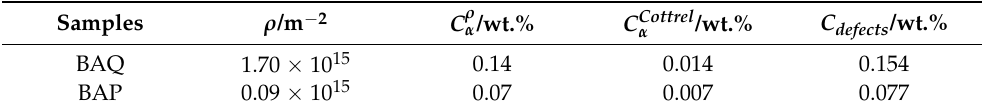
Table 3. The carbon content calculated in defects.